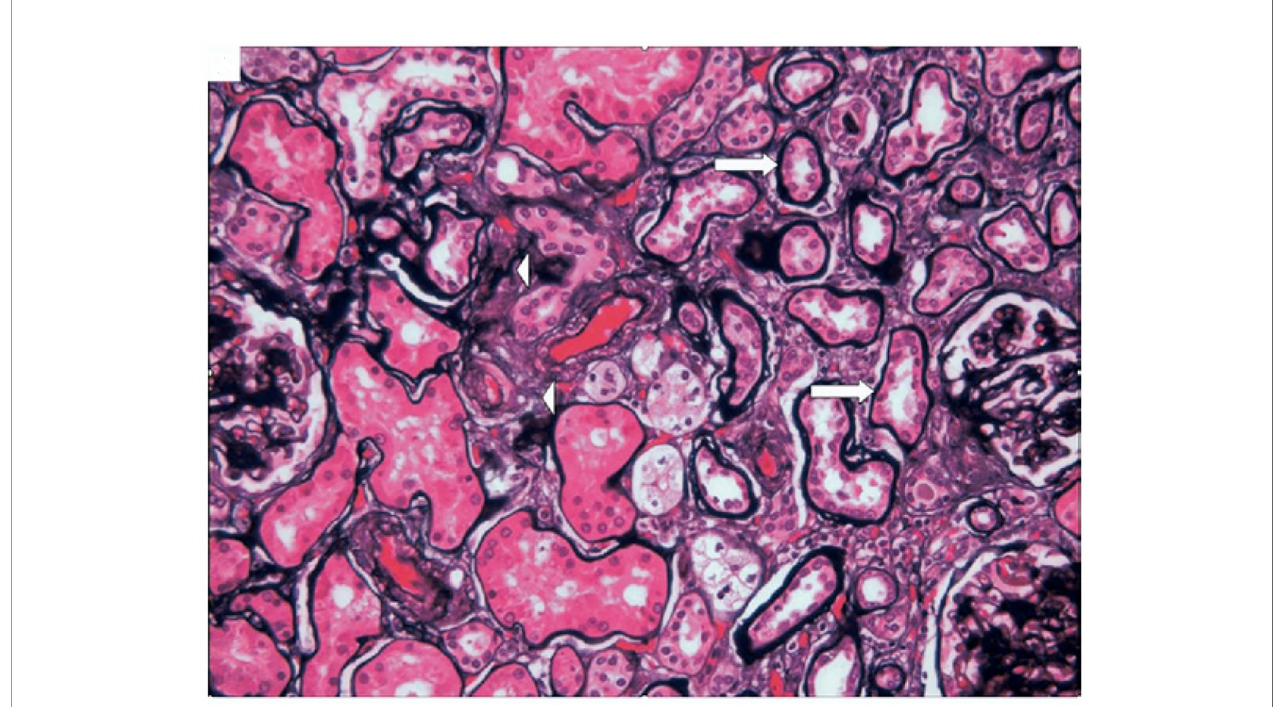
FIGURE 2 | Kidney pathological characteristics for patients with MetS. Tubular atrophy (arrows) and interstitial fi brosis (arrowheads), PASM. This picture is from Mariam P et al., 2009